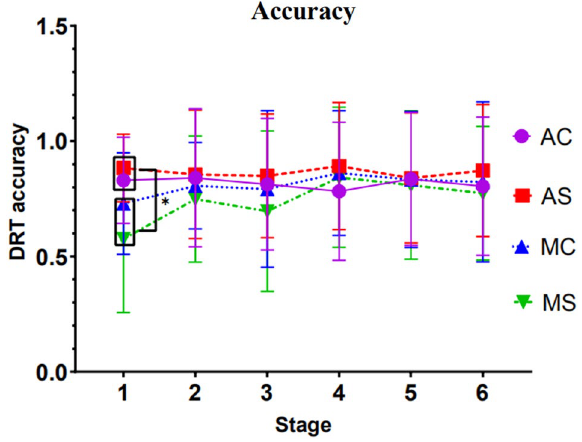
Figure 3. Trends in correct detection response task rates (Note: Vertical bars represent standard errors, *p <